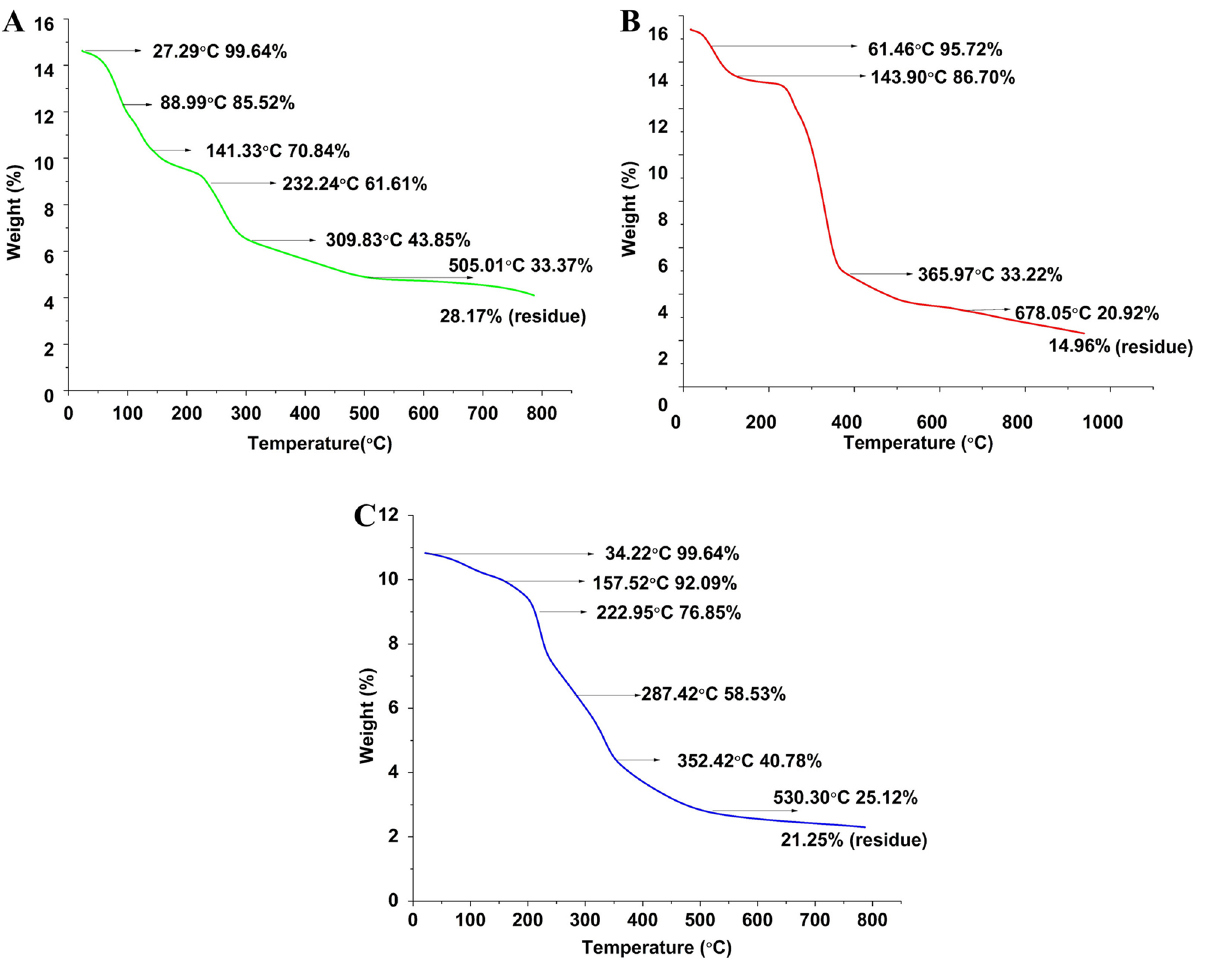
Figure 1. TGA profile of ( A ) Pj pods, ( B ) cellulose ( C )